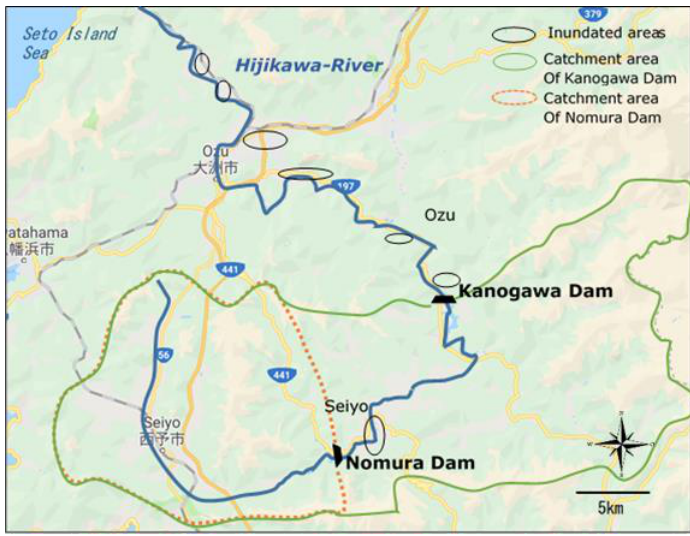
Figure 2. Location of two dams on the river.